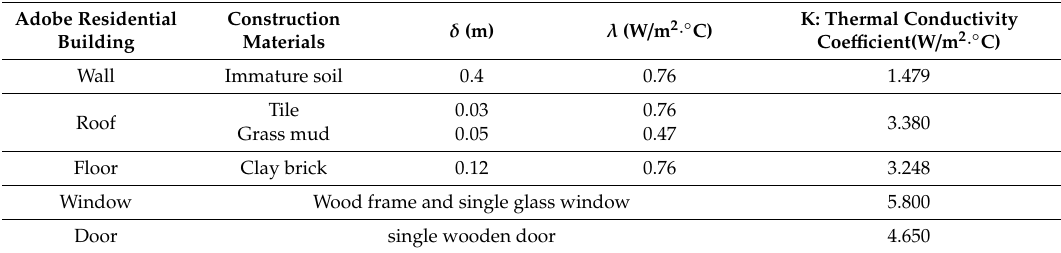
Table 11. Thermal conductivity coe ffi cient K i of adobe residential